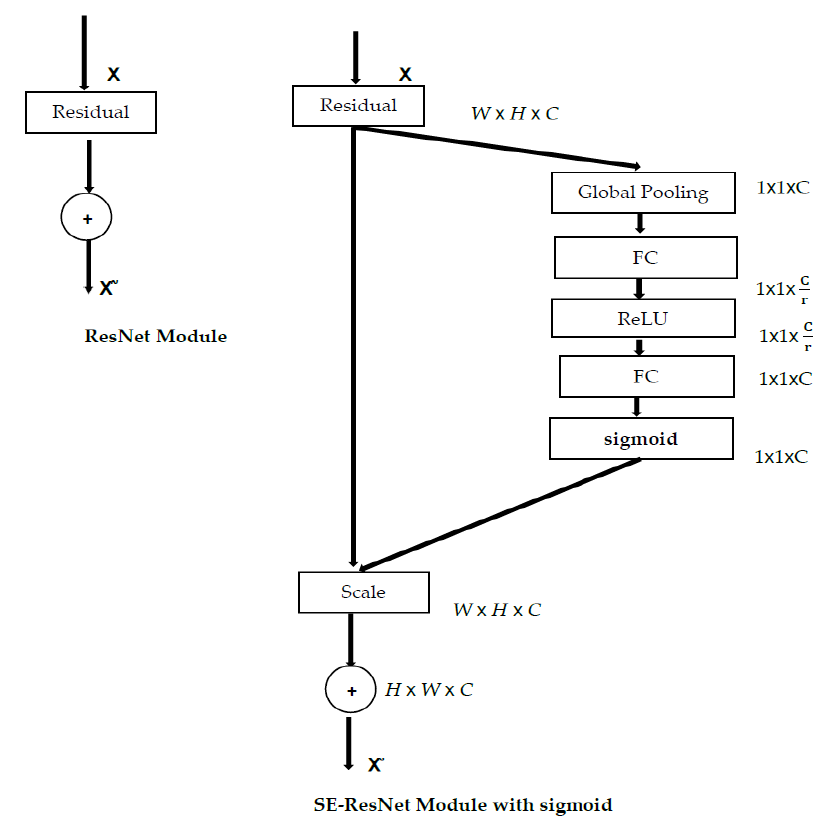
Figure 1. The schematic of the ResNet module with its SE.